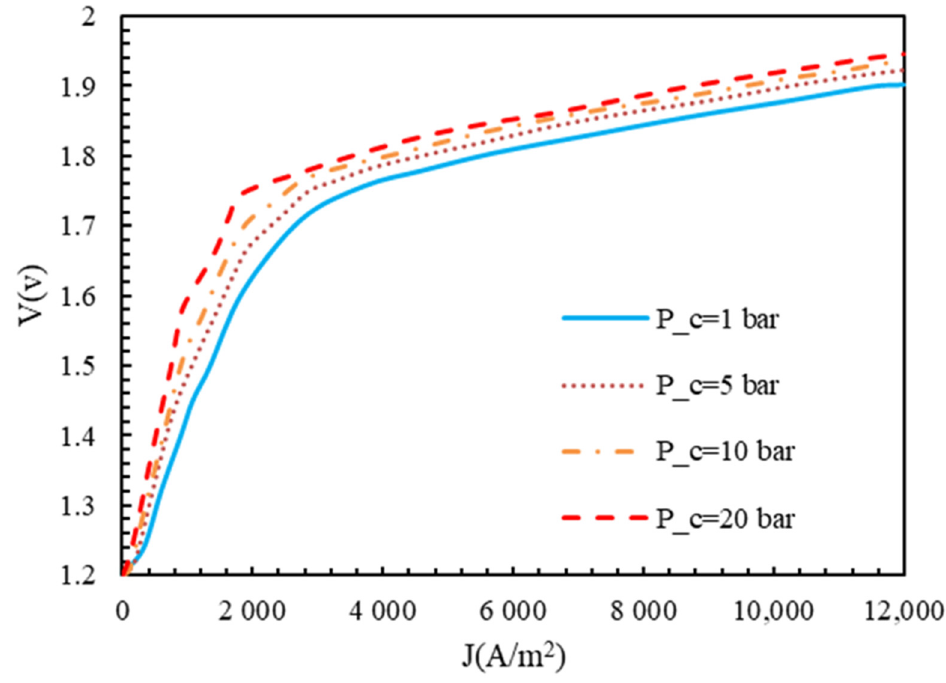
Figure 7. Polarization curve of polymer membrane electrolyzer at different pressures with T = 350 K, electrode catalyst of platinum, and membrane of Nafion.